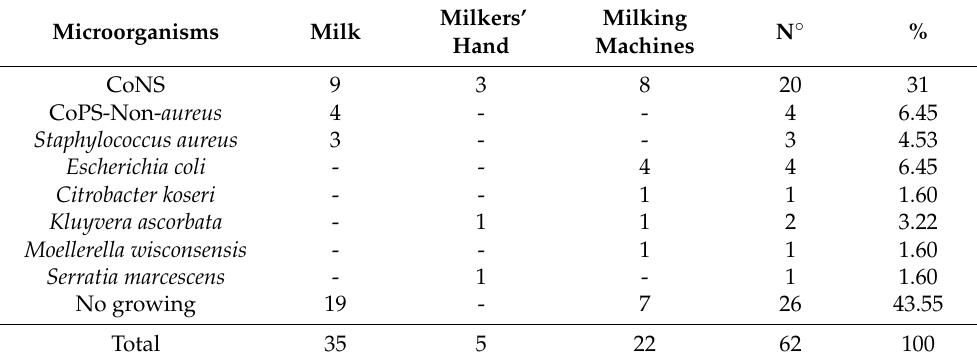
Milkers’ Milking Hand Machines